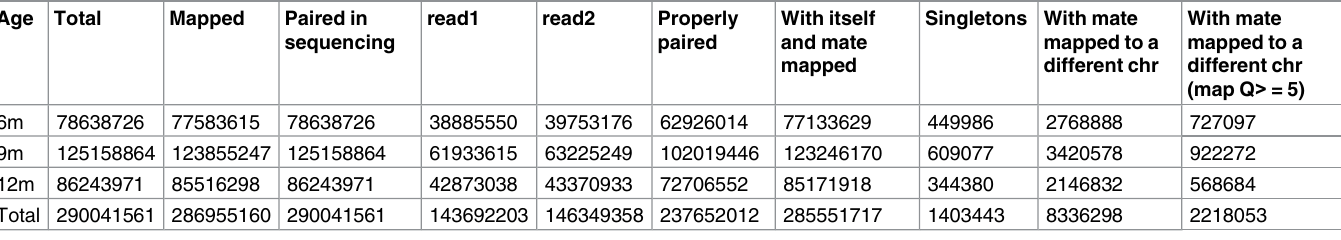
Table 3. Transcriptome mapping profile of liver tissue from the Polish HF cattle breed aligned to bovine referenceUMD3.1 genome assembly. Age Total Mapped Paired in